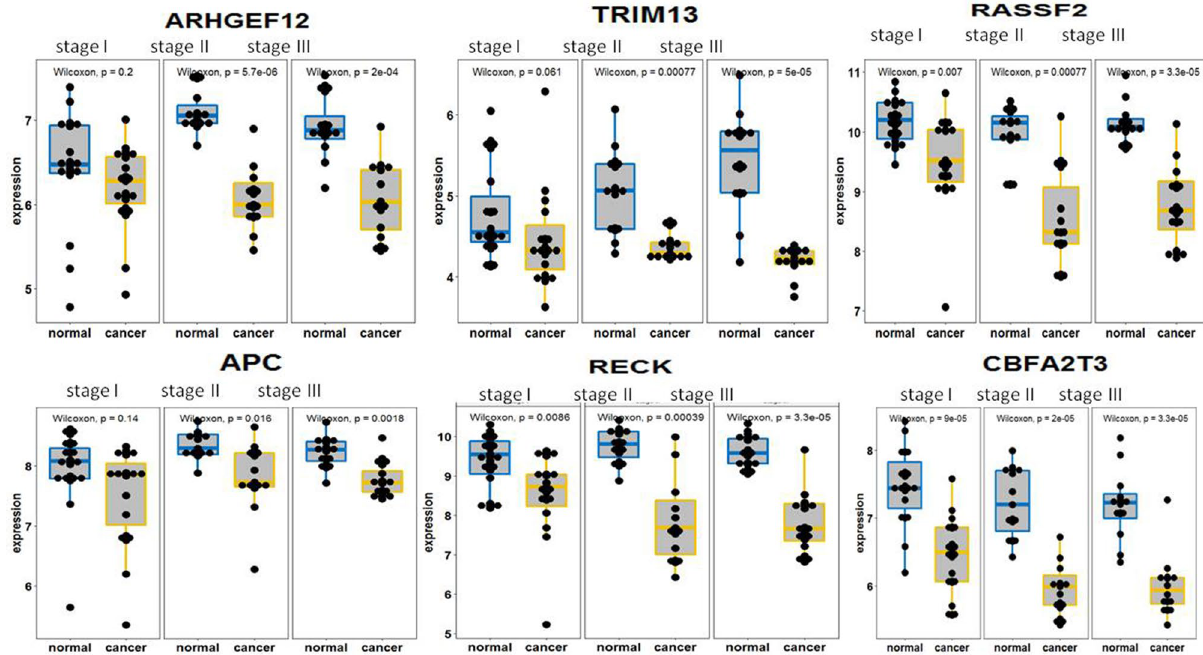
Figure 3. Boxplots for differential expression of tumor suppressor genes. Differential expression of 26 tumor suppressor (TS) genes between the normal and cancer samples at stages 1, 2 and 3 was displayed by boxplots where p-value is given for t-test for difference in expression of each TS gene between the normal and cancer samples. Here boxplots just show differential expression of TS genes EXT1, LIMD1, DAB2IP, DDX4, SASH1 and MCC between the normal and cancer samples at three tumor stages. The differential expression of the other 20 tumor suppressor genes was shown in supplementary Fig.